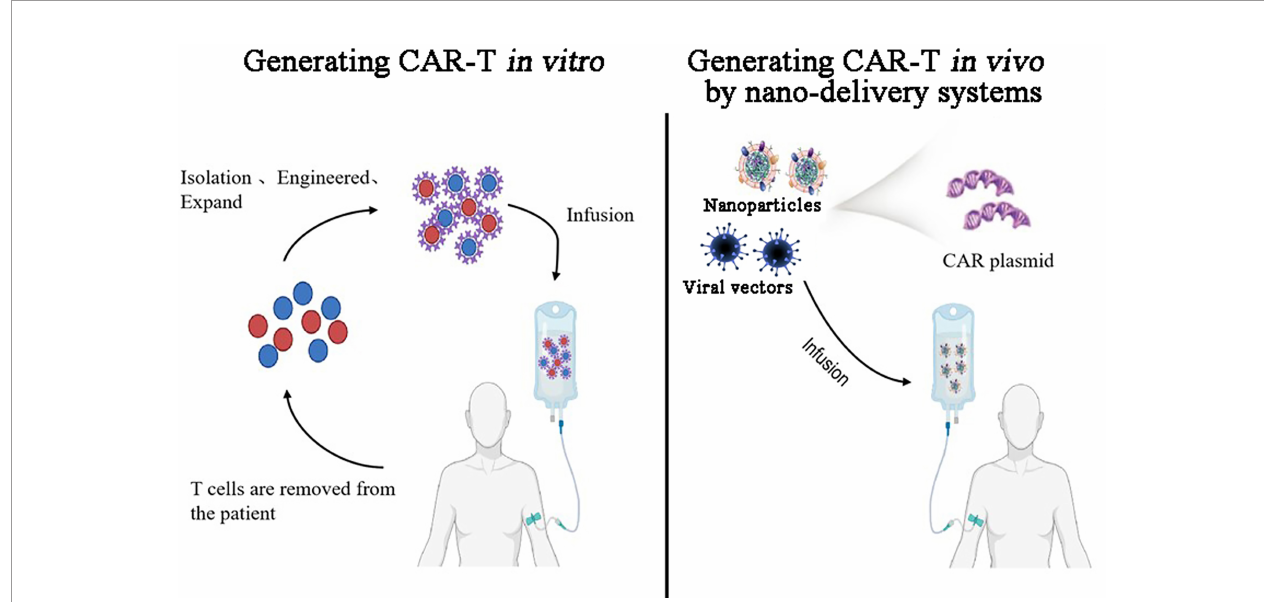
FIGURE 5 | Comparison of generating CAR-T in-vitro and generating CAR-T -in-vivo by nano-delivery systems: In-vitro CAR T cells are fi rst isolated from the patient, proliferated in-vitro , and then genetically engineered to screen the successfully edited CAR T cells, which are ampli fi ed to a certain number of infusions into the patient. In-vivo induced CAR T cells use nanotechnology to encapsulate CAR-expressing plasmids into nano-delivery systems including polymer nanoparticles and viral vectors such as lentivirus and AAV, which are then targeted to tumor regions in-vivo to edit T cells in-situ at tumor sites to kill tumors.